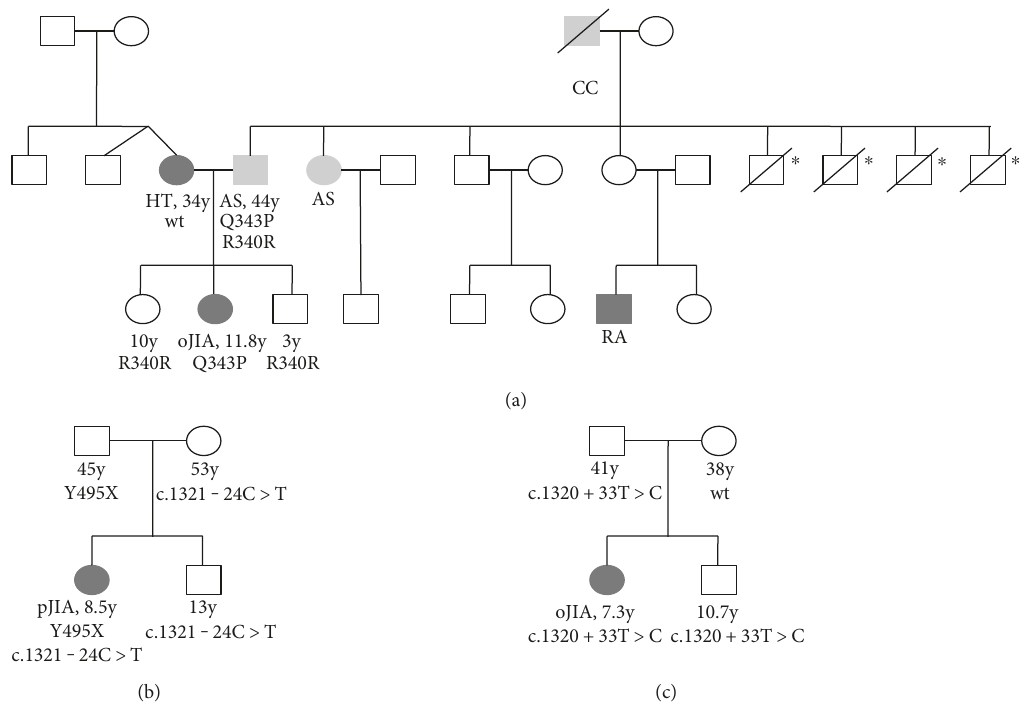
Figure 2: Pedigrees of patients with autoimmune juvenile arthritis and novel SIAE mutations. (a) Pedigree of the family with the p.Q343P variant; (b) pedigree of the family with the p.Y495X variant; (c) pedigree of the family with the c.1320+33T > C variant. Patients with autoimmunity are depicted in dark grey (HT, Hashimoto ’ s thyroiditis; oJIA, oligoarticular JIA; pJIA, polyarticular JIA; and RA, rheumatoid arthritis). Patients su ff ering from other diseases are shown in light grey (AS, asthma; CC, colorectal carcinoma). All identi fi ed SIAE variants were in heterozygous state. The age of the individuals for whom genetic analysis was performed is also presented. ∗ Individual II-11: death by car accident; individuals II-12, − 13, and − 14: death during